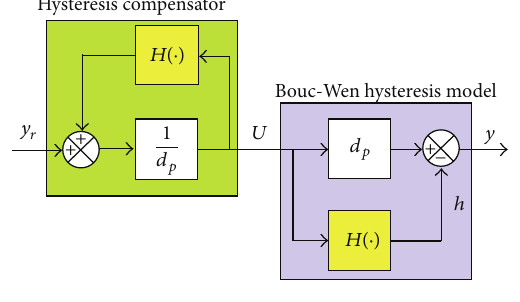
Figure 24: Bouc-Wen based compensator